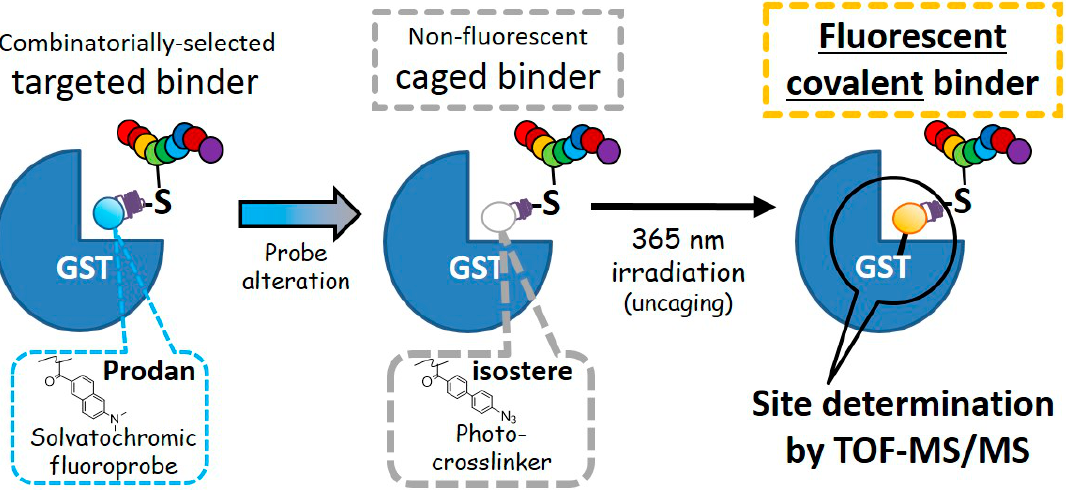
Figure 1. Determining the binding-site of a combinatorially-selected peptide using a rationally designed photo-crosslinker, which is a bioisostere of the solvatochromic fluoroprobe present in the parent peptide. Irradiation with UV light simultaneously crosslinks the fluorophore to the protein binding site and uncages the fluorescence property by forming an intramolecular charge transfer (ICT) structure. This facilitates the rapid deduction of the binding site of the peptide using SDS-PAGE with fluorescence imaging followed by tandem MS analysis. The dotted line stands for the fluorescent color of each